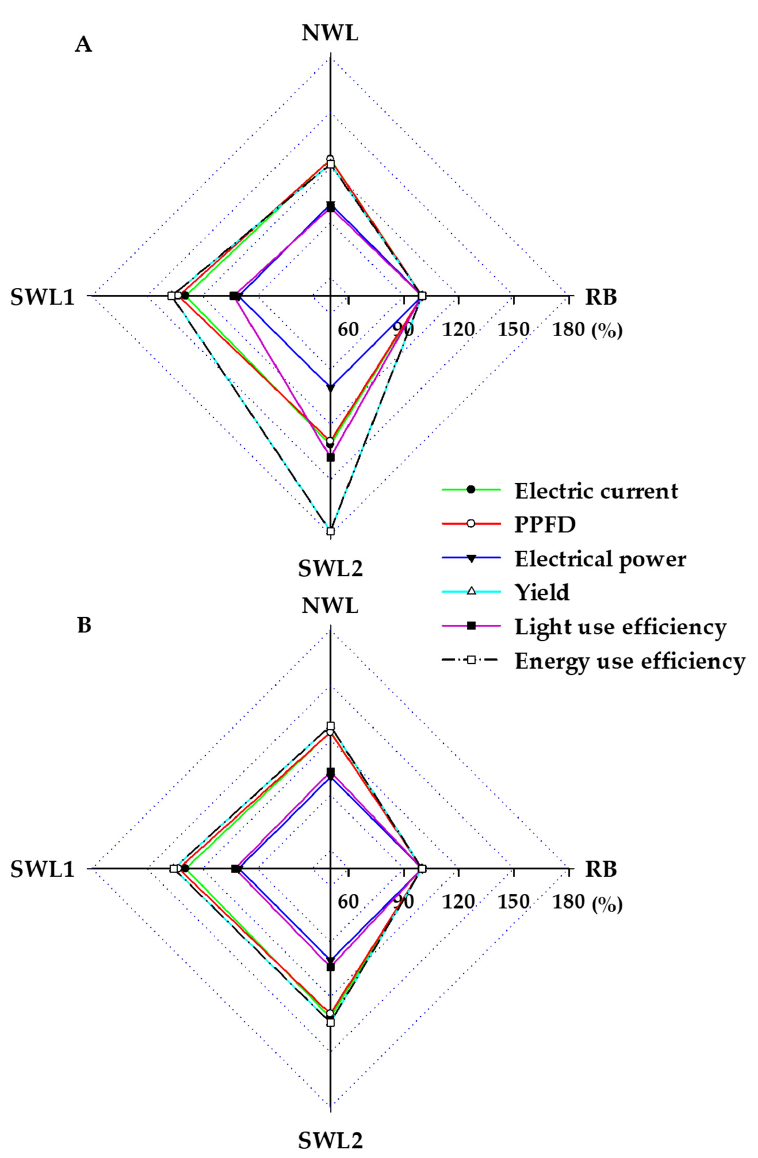
Figure 5. Electric current, PPFD, electricity, yield, light use efficiency, and energy use efficiency of butterhead lettuce ( A ) and romaine lettuce ( B ) plants grown under various light sources with the same electrical power after 4 weeks of transplanting.